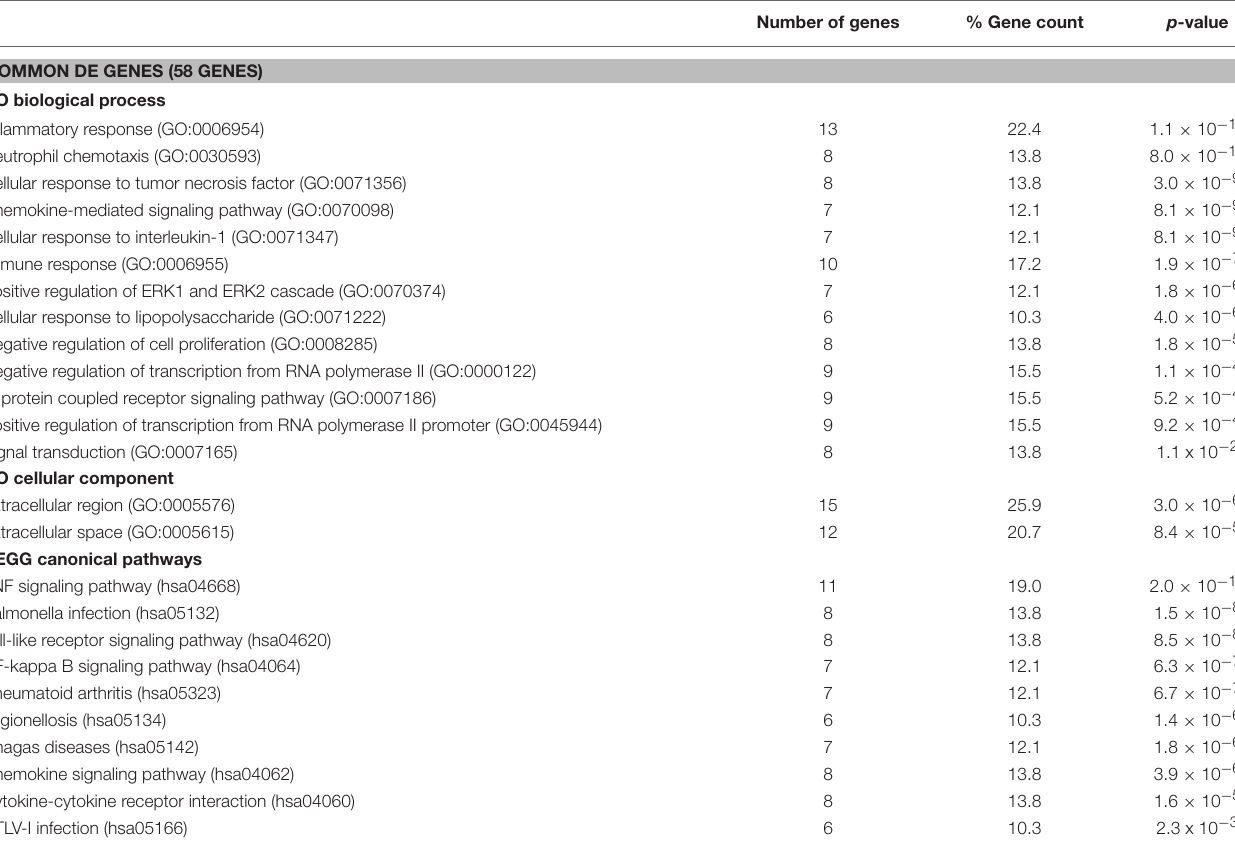
TABLE 1 | Categorization of the 58 DE genes commonly altered by the infection of either R. conorii or R. montanensis .